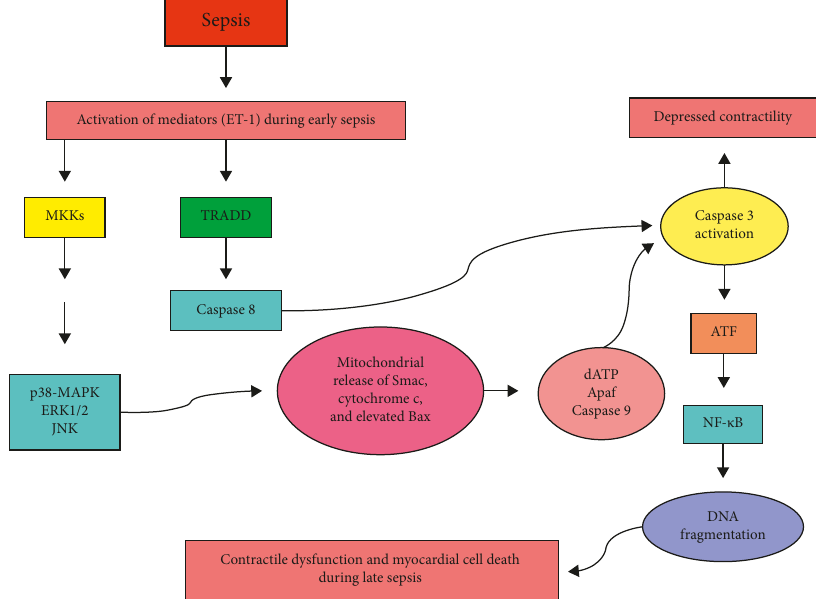
Figure 3: Cellular events involved in the induction of apoptosis through activation of extrinsic and intrinsic pathways in sepsis. See the text for detailed information. Apaf: apoptosis protease activating factor-1; ATF: activating transcription factor 1 and/or 2; Bax: Bcl-2 associated x protein; ERK1/2: extracellular signal-regulated kinase 1/2; ET-1: endothelin-1; JNK: c-Jun N-terminal kinase; NF- κ B: nuclear factor κ B; p38- MAPK: p38-mitogen-activated protein kinase; Smac: second mitochondria-derived activator of caspases; TRADD: TNF receptor-associated death